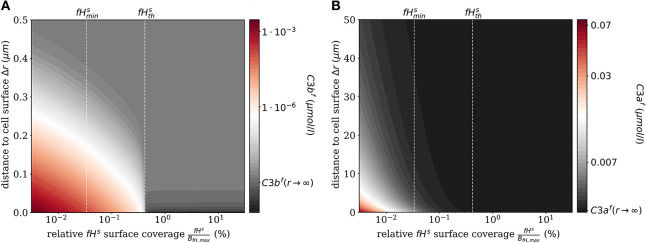
Steady states of the molecules C3bf and C3af in the fluid phase for varying surface-bound Factor H concentrations. (A) Radial steady state concentration profile of the fluid-phase C3bf concentration. (B) Radial steady state concentration profile of the fluid-phase C3af concentration. Mind the different scales in (A,B).